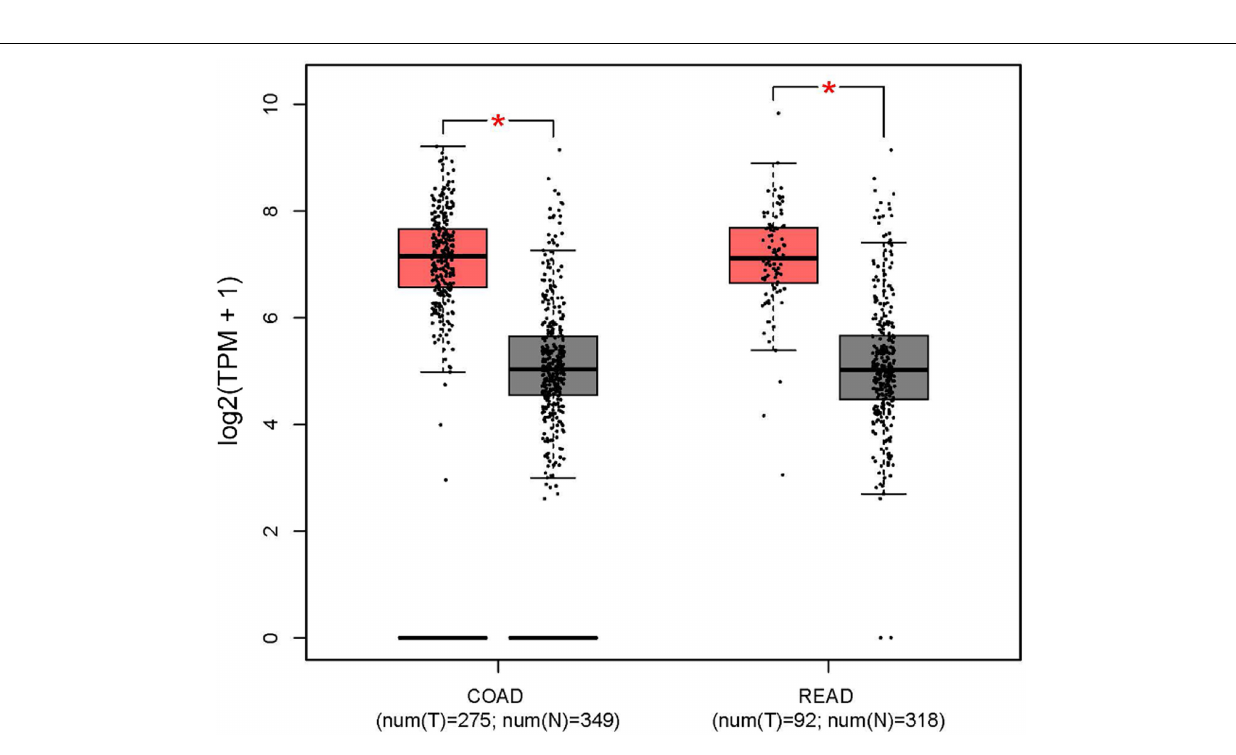
Frontiers in Genetics |